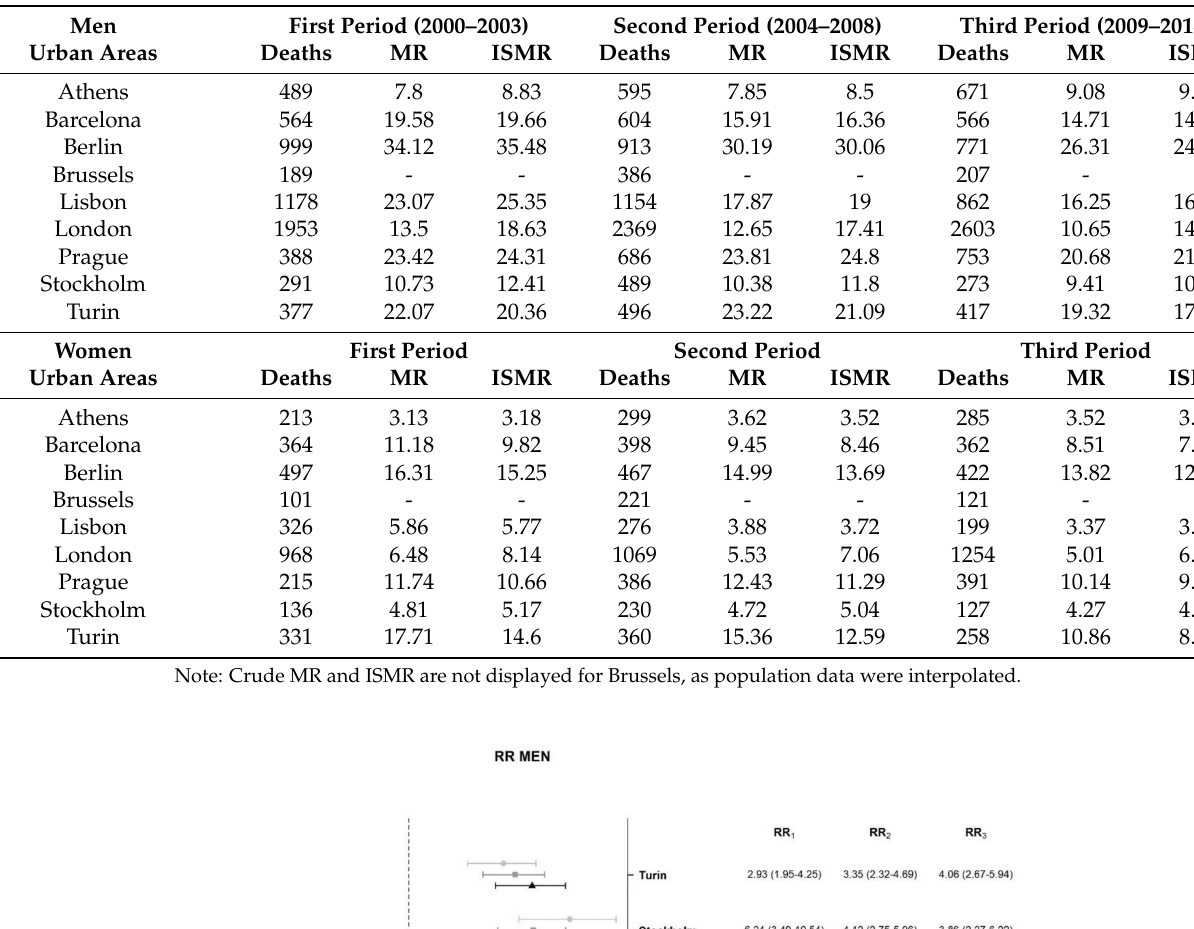
Table 2. Number of deaths, crude mortality rate (MR), and indirectly standardised mortality rate (ISMR) per 100,000 inhabitants for men and women for each study period.